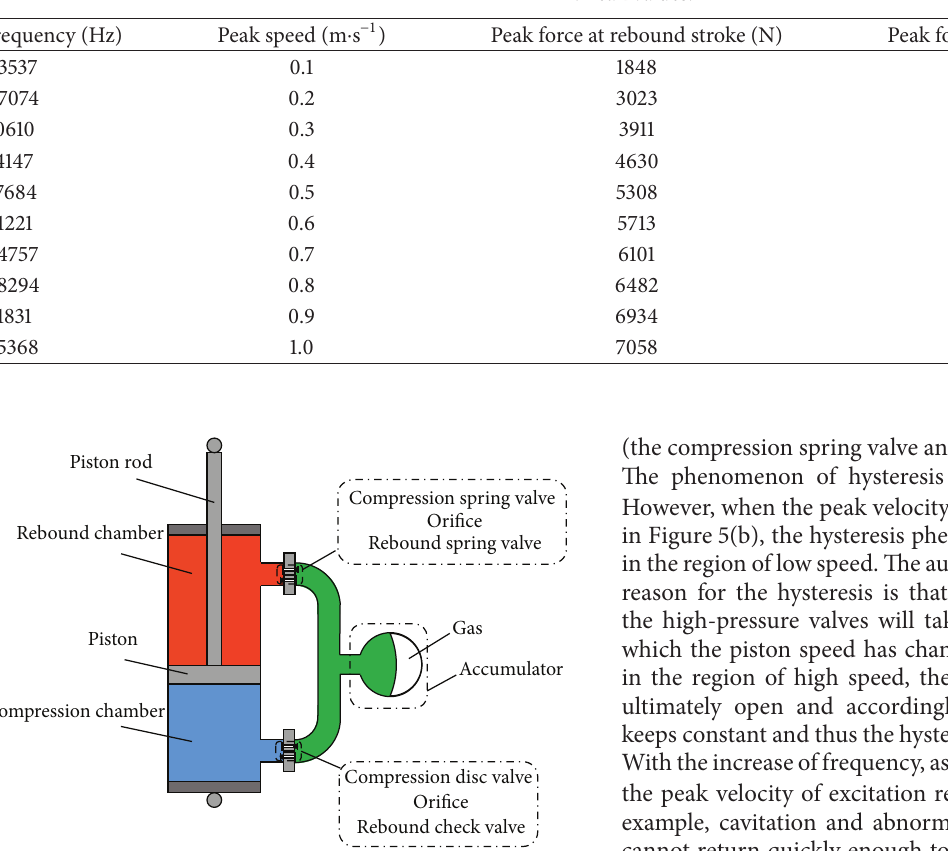
Figure 1: Roll-plane HIS system [5]. Table 1: Peak values.